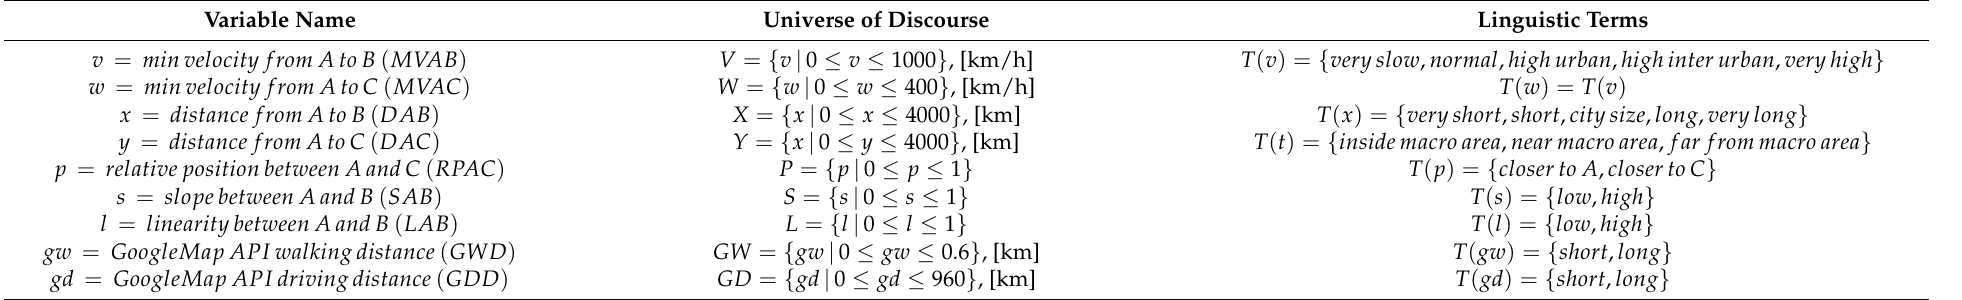
Table 2. Fuzzy Logic NNH Fix Algorithm (FNFA) model’s linguistic variables, universe of discourse, and linguistic